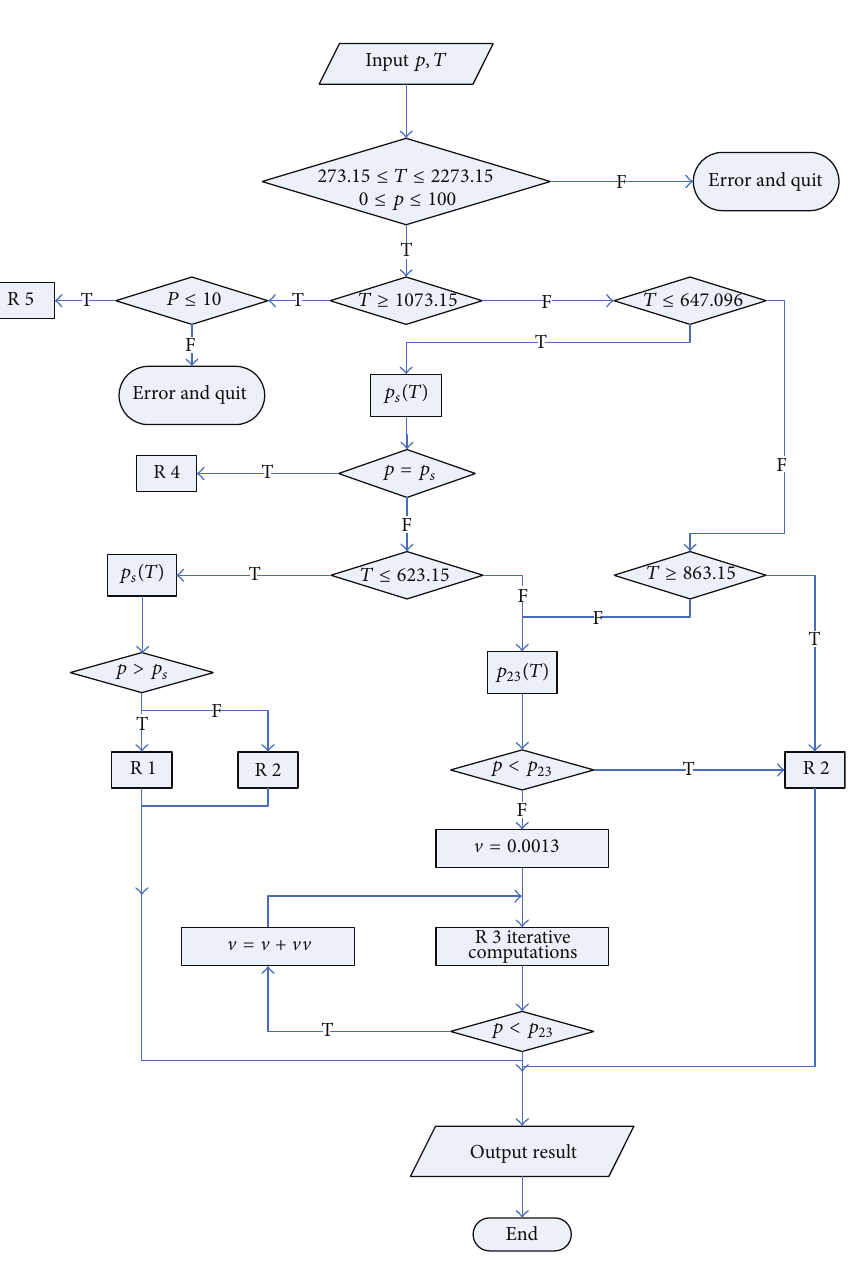
Figure 2: Flow chart of thermodynamic properties subroutine based on